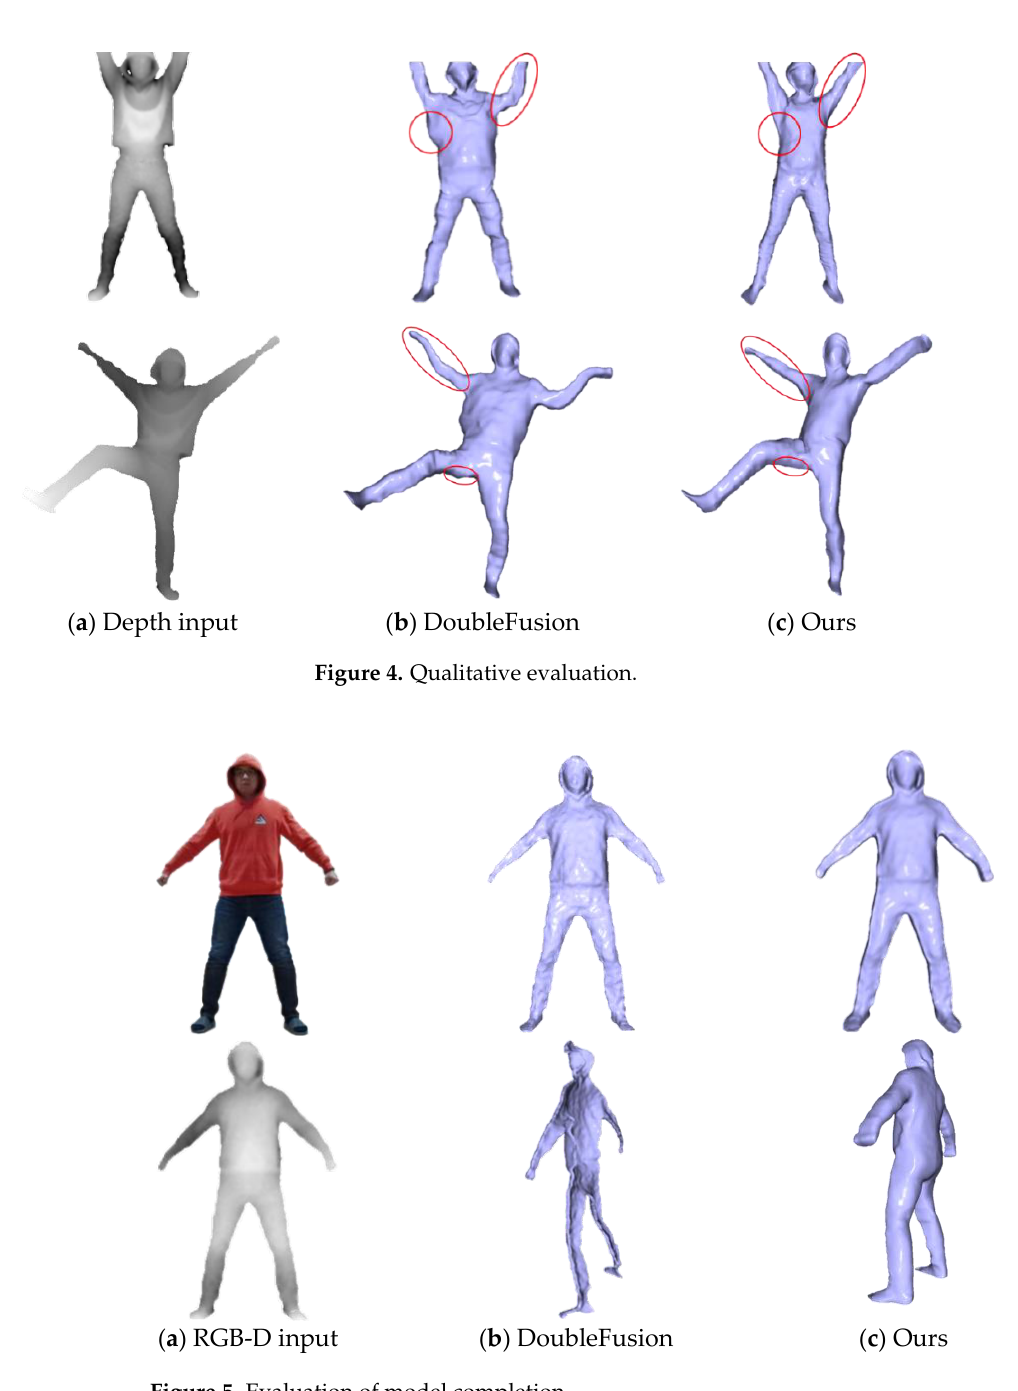
Figure 5. Evaluation of model completion.